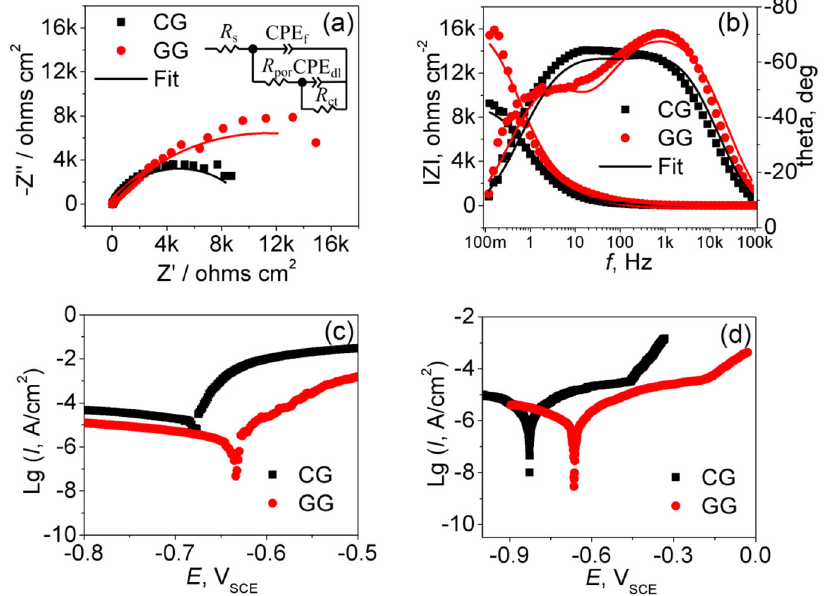
Fig. 8 Comparison of electrochemical corrosion properties for CG and GG samples. a Nyquist plots and b Bode plots in naturally aerated 3.5 wt% NaCl solution; Polarization curves in c 3.5 wt% NaCl solution and d 0.1 mol/L Na 2 SO 4 + 20 mmol/L NaCl.